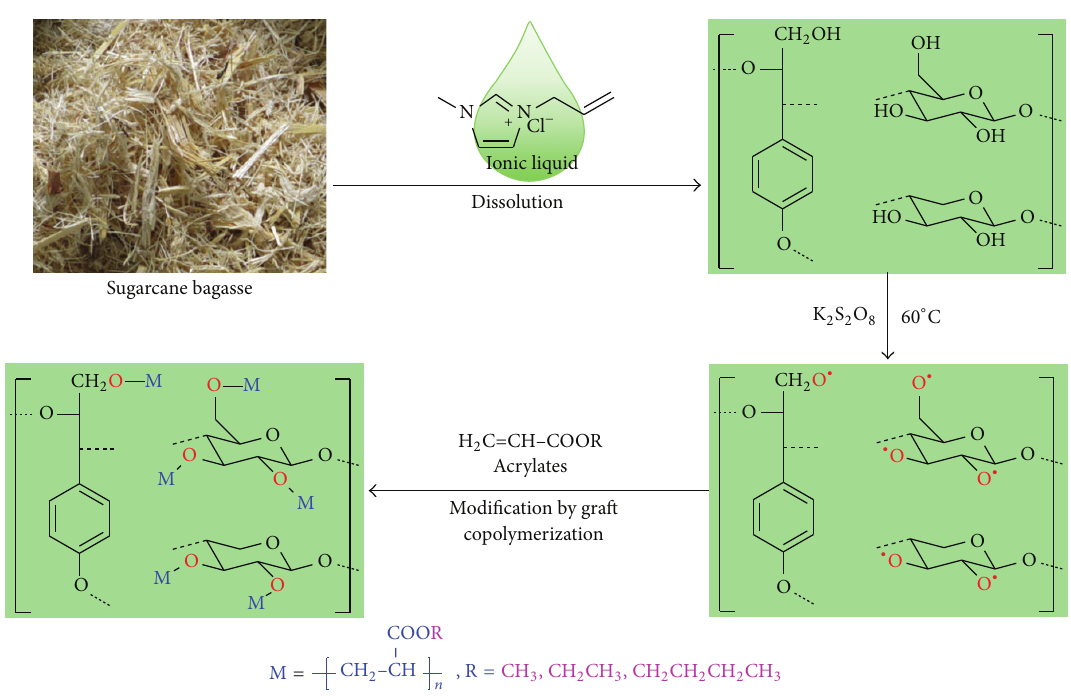
Figure 1: Chemical processes for sugarcane bagasse modification by free radical initiated graft